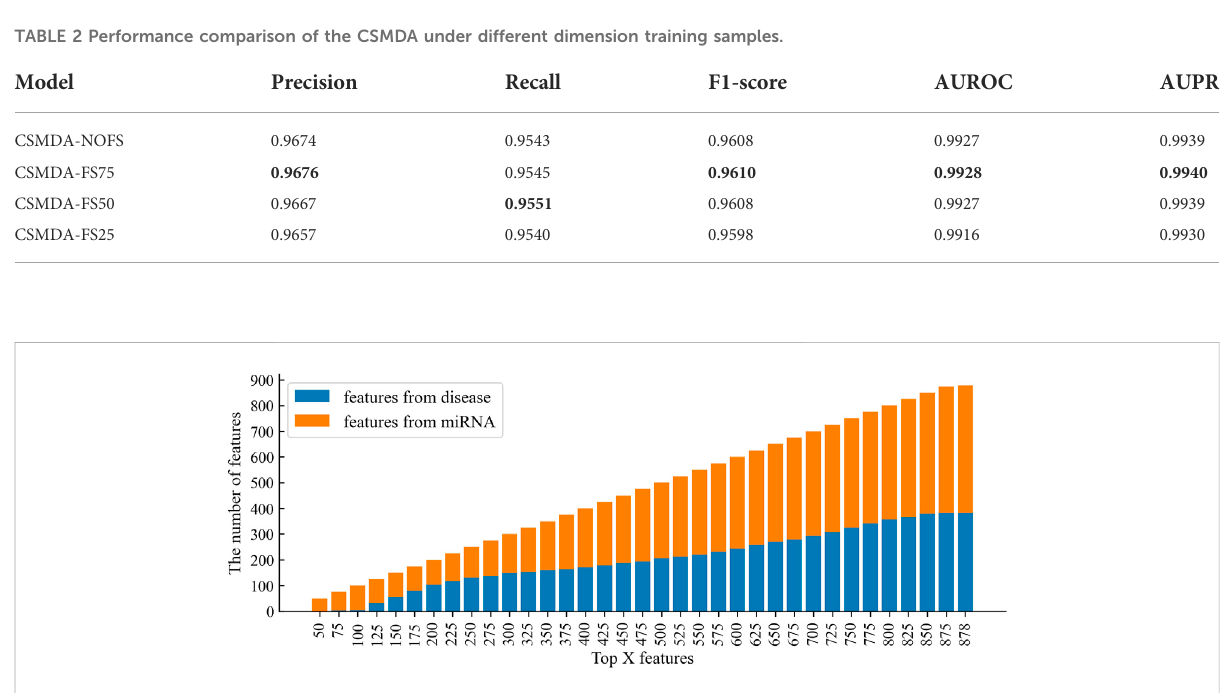
FIGURE 5 The distribution of features from miRNAs and diseases among the top X